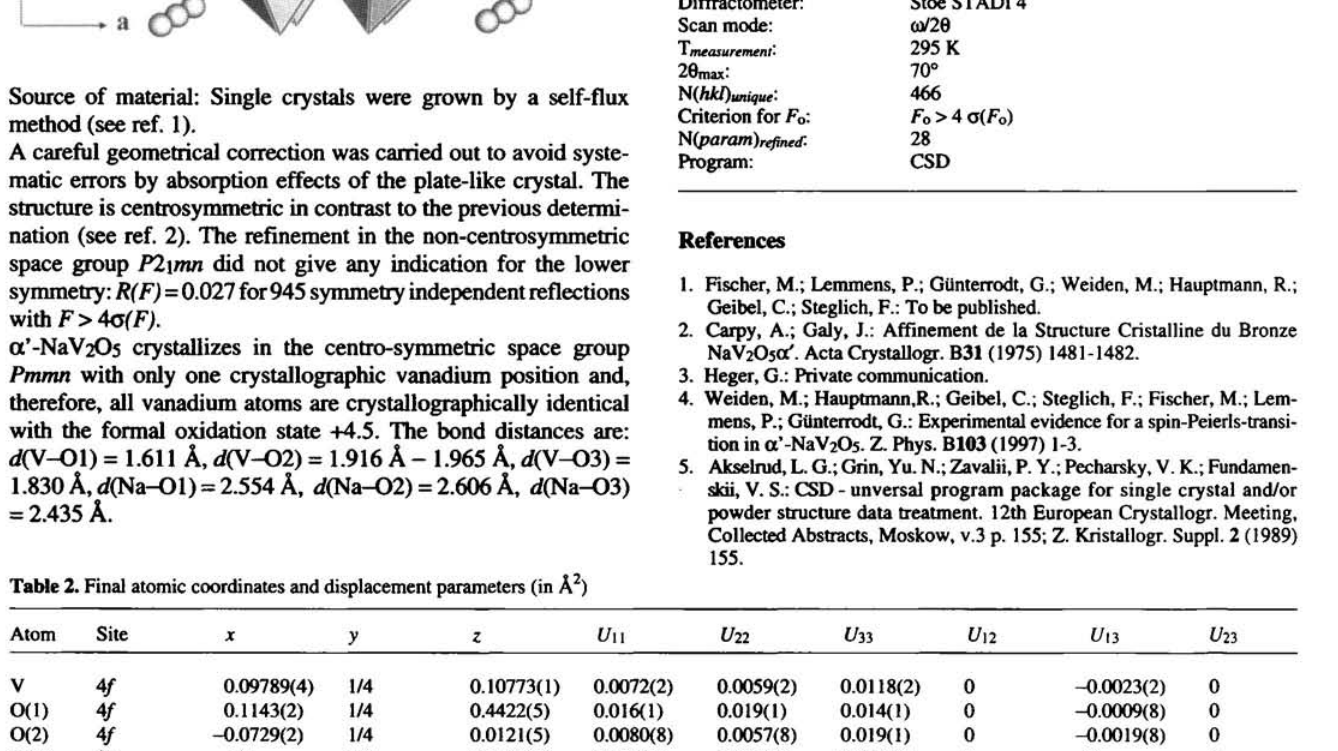
Table 2. Final atomic coordinates and displacement parameters (in Â^)